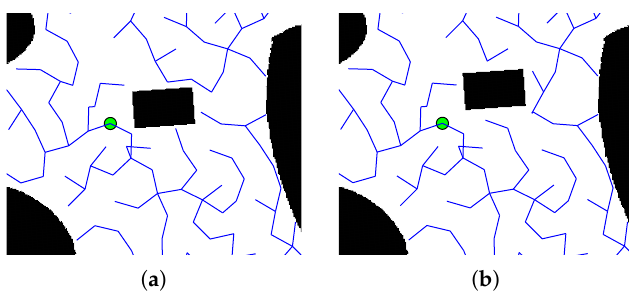
Figure 16. The blank area was filled by a new node. ( a ) The tree before. ( b ) A new node is generated behind the obstacle to fill the empty area, which ensures the pervasive of the tree.